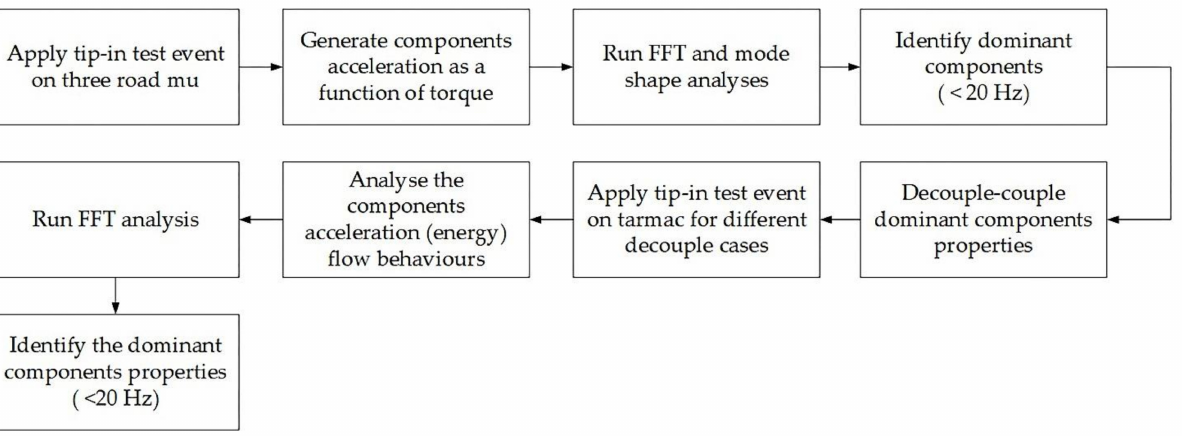
Figure 6. EPA process to determine the dominant component low-frequency